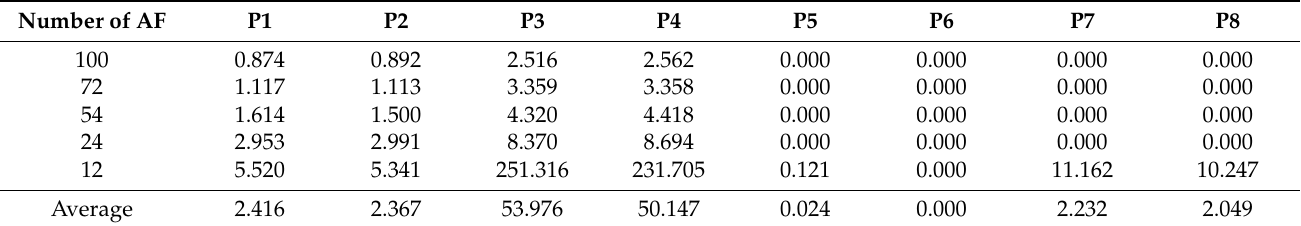
Table 5. Average error of random deployment in target positioning.